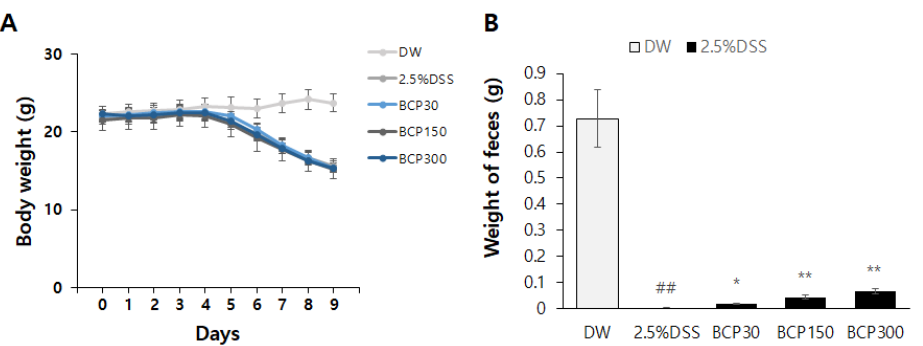
Figure 1. The body weight and feces weight following the administration of β -caryophyllene (BCP) in the dextran sulfate sodium (DSS)-induced colitis model. The body weight ( A ) and feces weight ( B ) were measured and evaluated in each group. Data are presented as mean of ± SEM. Group comparisons were accomplished using one-way ANOVA test and unpaired t -test with post-test (##, p < 0.01, compared to vehicle-treated control mouse) (*, p < 0.05; **, p < 0.01, compared to vehicle-treated, 2.5% DSS-induced colitis mouse).